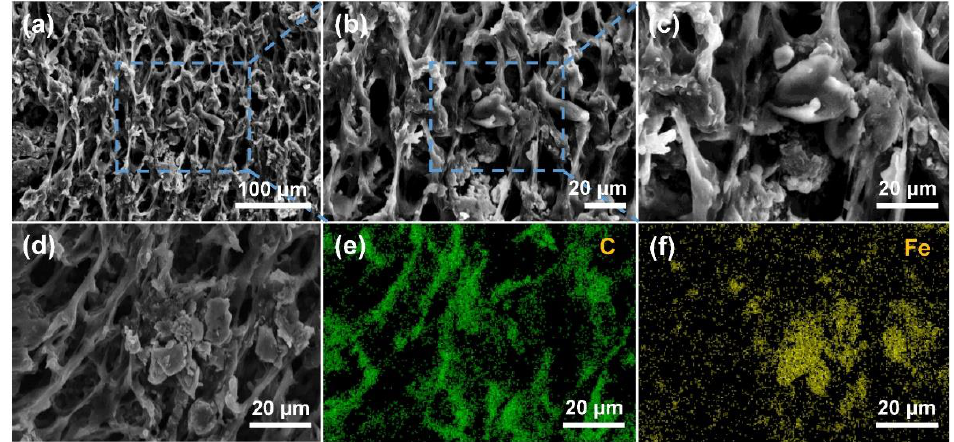
Figure 2. ( a – d ) SEM images of the PU/WTR@CNT/Fe 3 O 4 composite foam with ( e ) C, and ( f ) Fe element mapping.